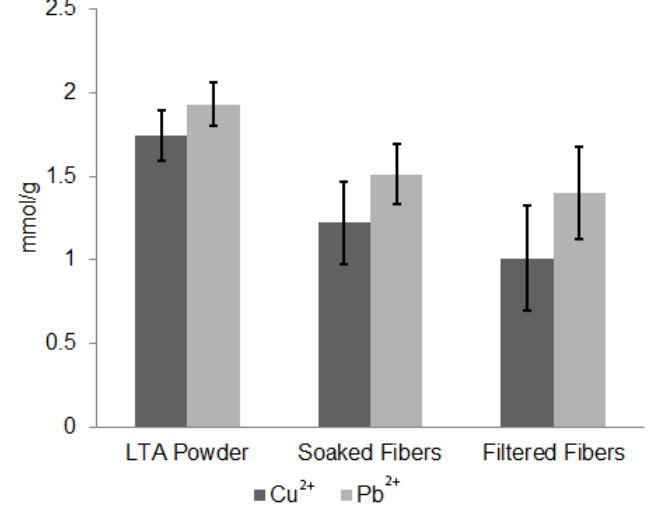
Figure 7. Ion exchange capacity of LTA in porous CA fibers for Cu 2+ and Pb 2+ .